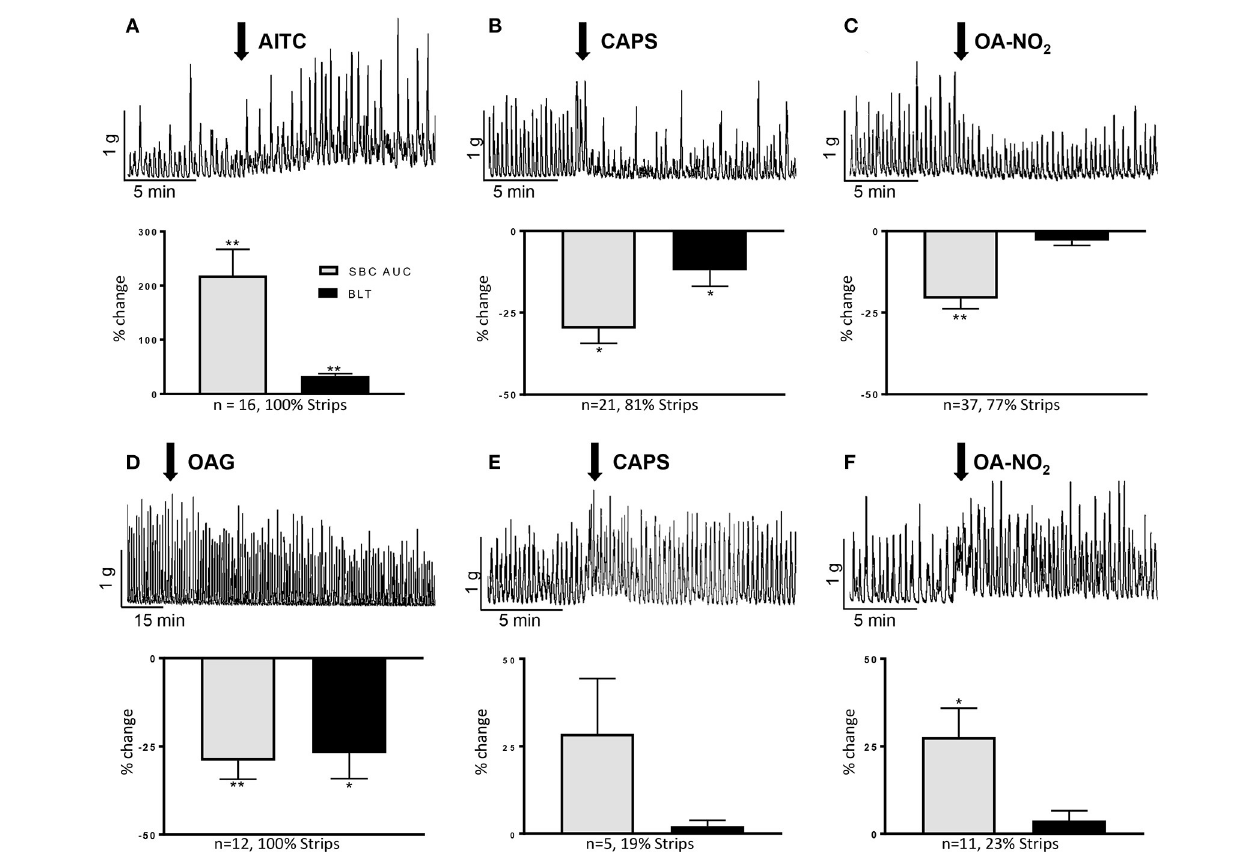
FIGURE 1 | Effects of AITC (100 µ M), capsaicin (CAPS, 1 µ M), OA-NO 2 (30 µ M), and OAG (50 µ M) on guinea pig spontaneous bladder contractions (SBCs). (A–C) Upper traces show the common excitatory response of AITC and inhibitory responses of CAPS and OA-NO 2 . Drugs were applied at the arrows and maintained in